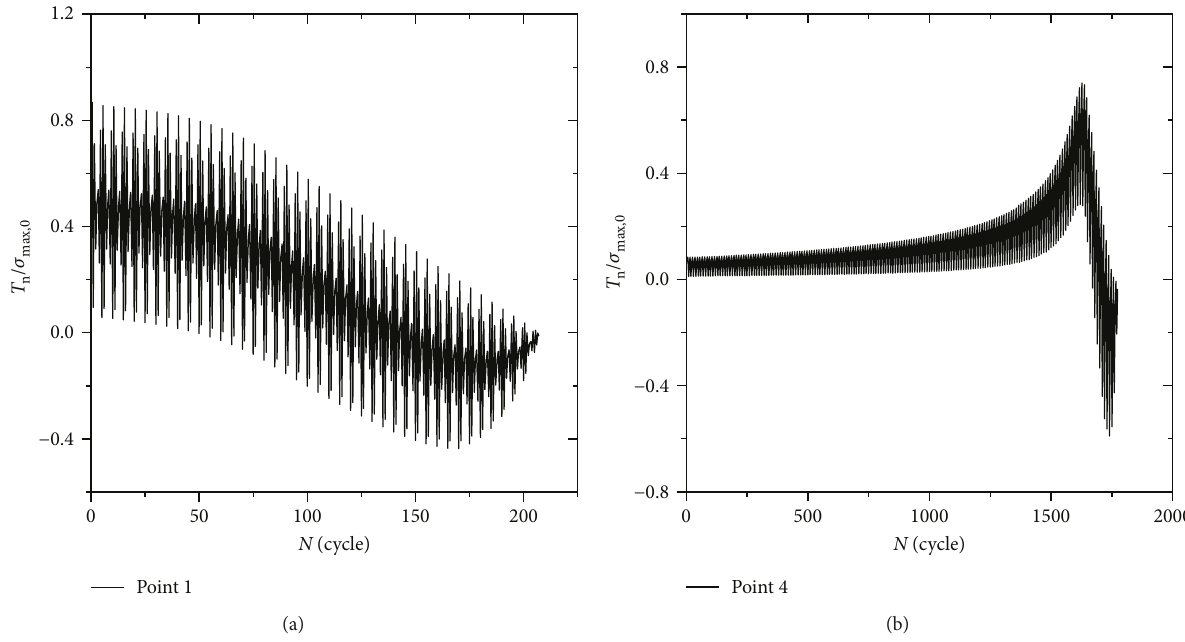
Figure 10: The traction against the number of applied cycles is compared between (a) point 1 and (b) point 4, and the constant loading amplitude is carried out with F max = 24 kN at R = 0 1 , which corresponds to the initial stress intensity factor range Δ K i = 76MPa m 1/2 for the CT